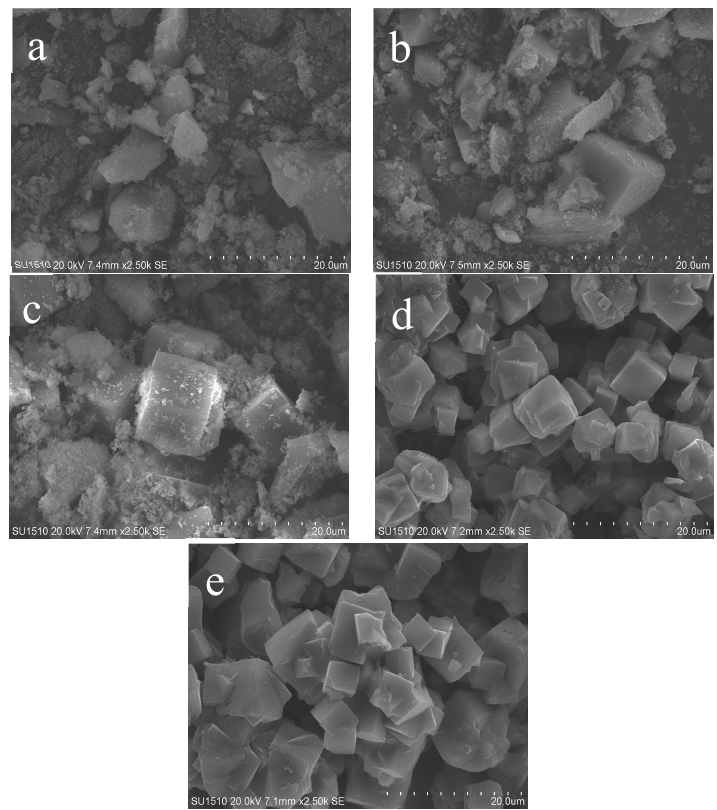
Figure 8. SEM images of S–Si–SOD zeolites crystallized at 200 ◦ C for ( a ) 0, ( b ) 12, ( c ) 14, ( d ) 16, and ( e ) 24 h, respectively.